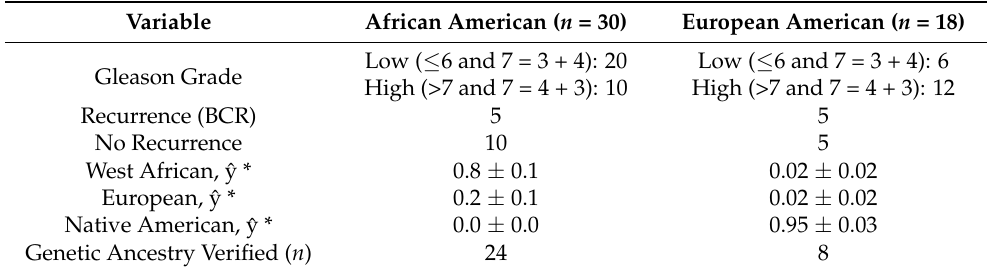
Table 1. Clinical parameters of prostate tumor samples used for lipidomics profiling. ˆy * represents the estimated value of the response variable.